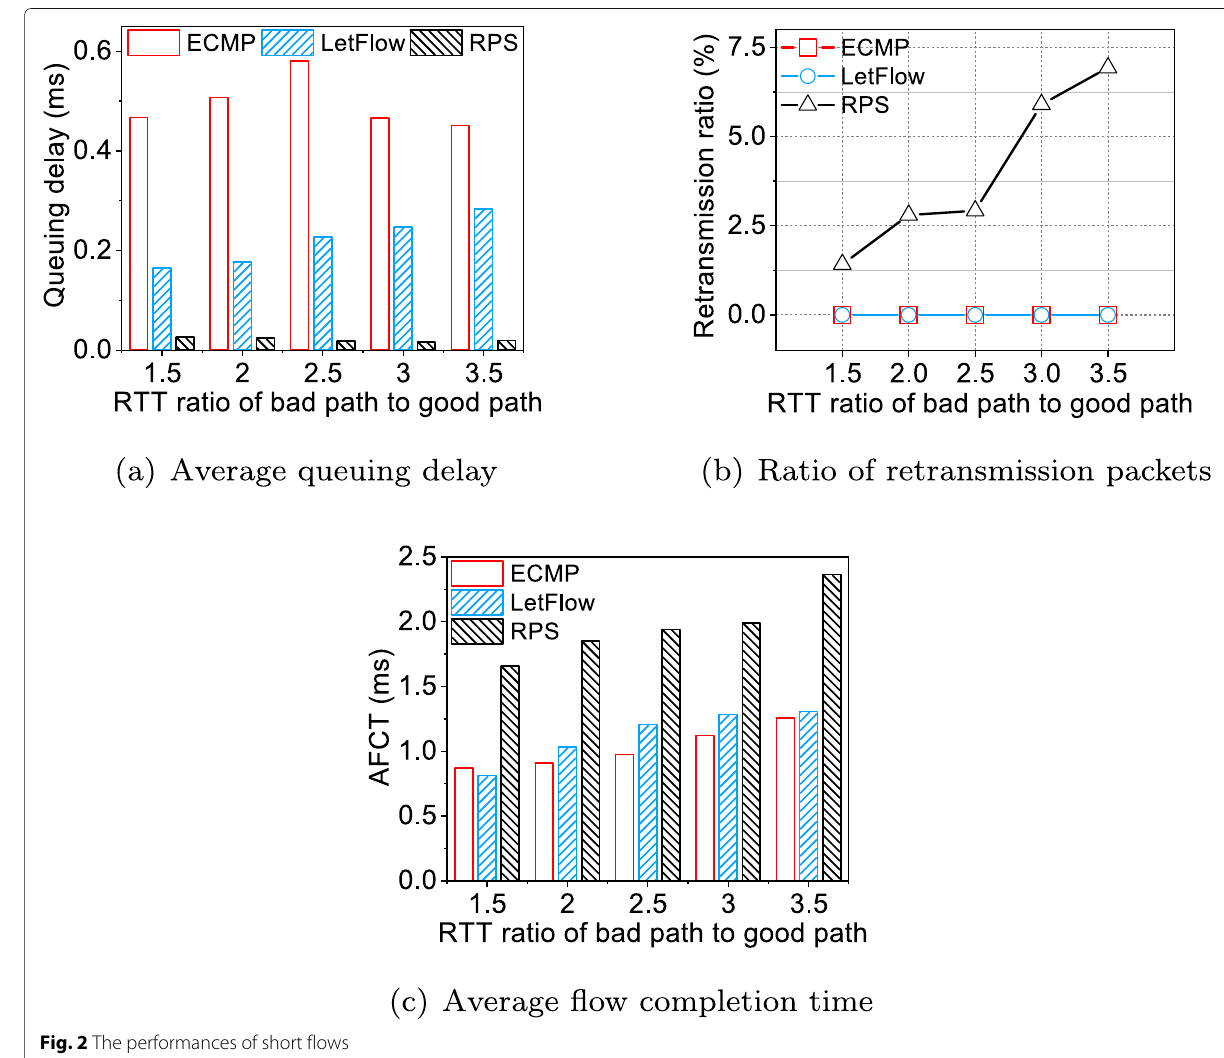
packet in the same flow. If the computed TNL of an out- put queue for the current packet is smaller than the stored TNL of its previous packet, the current packet will prob- ably reach the next leaf switch earlier than its previous packet once using this output queue, resulting in packet reordering. Otherwise, TR considers this output queue as an alternative output queue to forward the current